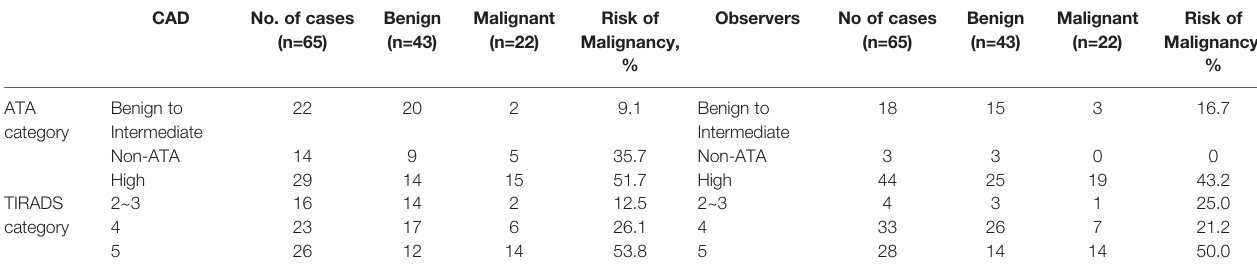
TABLE 4 | Malignancy rate based on the ATA and TIRADS category in 65 patients diagnosed with follicular neoplasm on